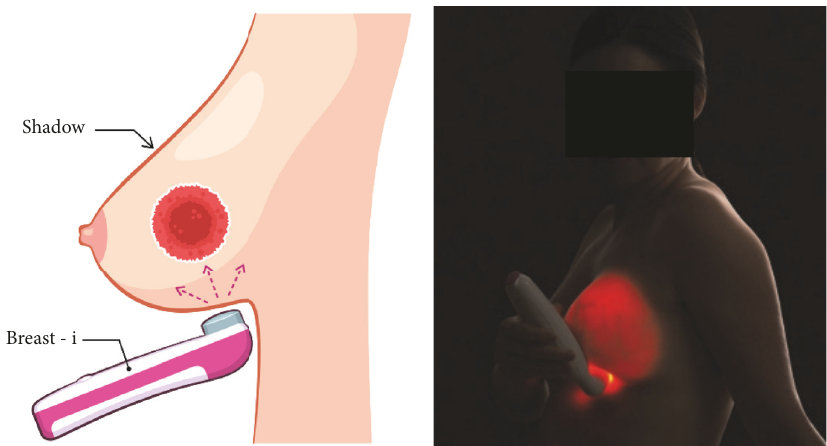
Figure 2: Illustration of how to use the optical device . In a darkened room, switch Breast-i on and place it underneath the breast. Adjust light intensity as required and view each breast looking out for any spots or shadows. Sometimes it is necessary to place the Breast-i on top of the breast and view underneath the breast directly or use a mirror. Light is scattered through the breast tissues giving it a uniform pink or red colour with blood vessels seen as dark